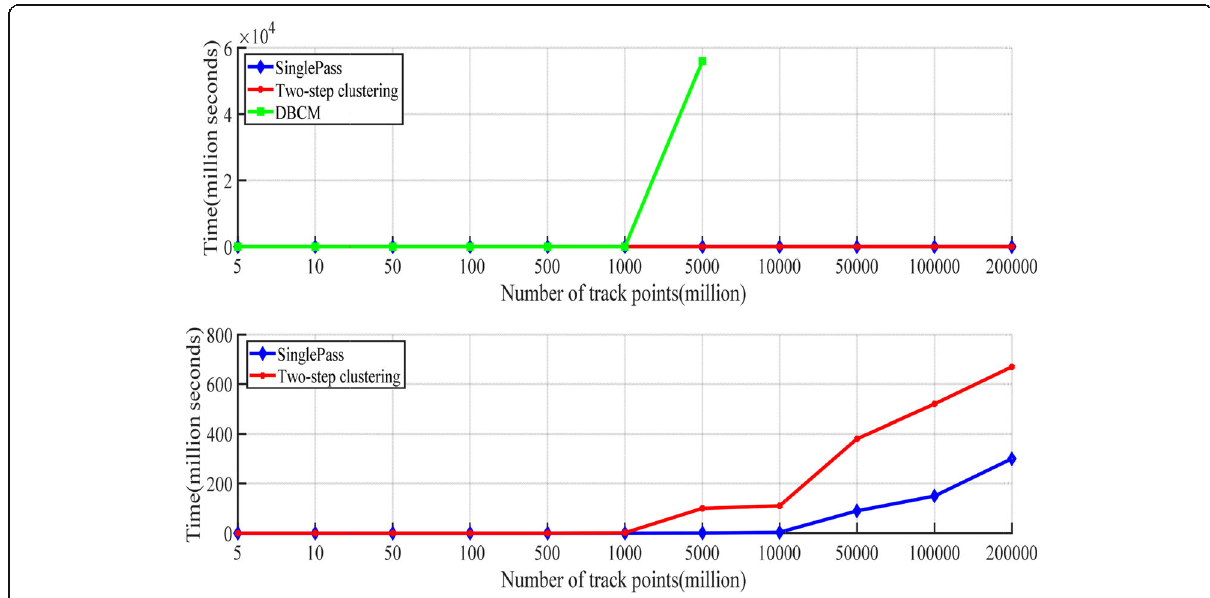
Fig. 6 Time-consuming comparison of three clustering algorithms